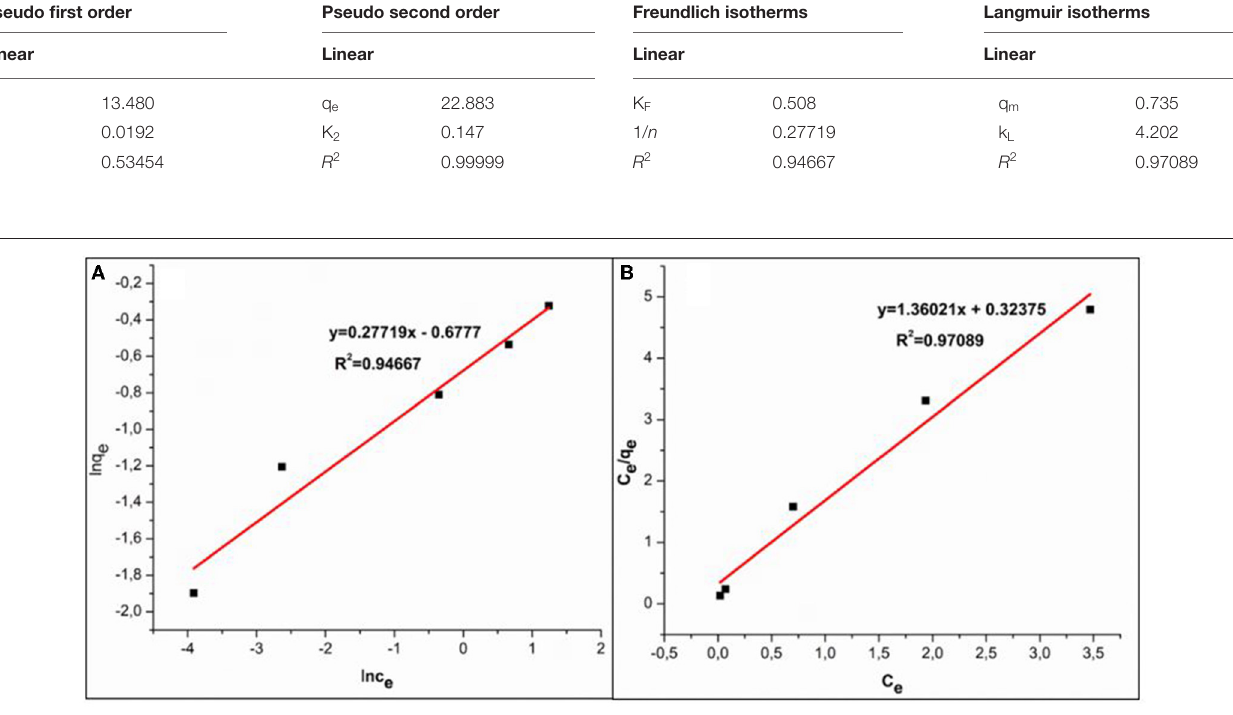
Frontiers in Water |